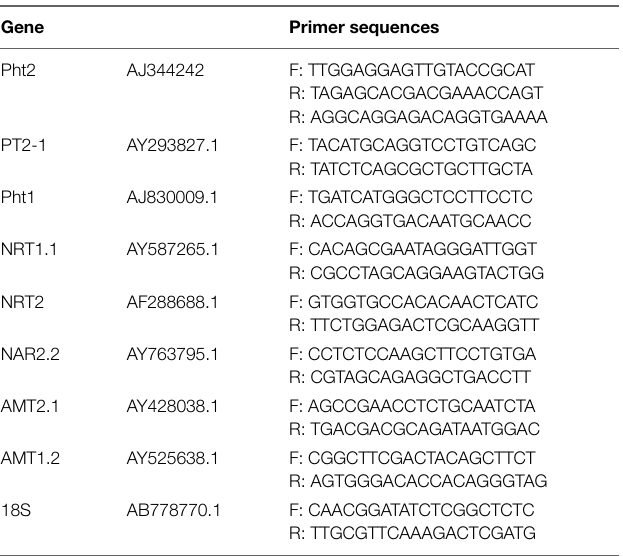
TABLE 1 | List of primers used in qRT-PCR analysis. Gene Primer